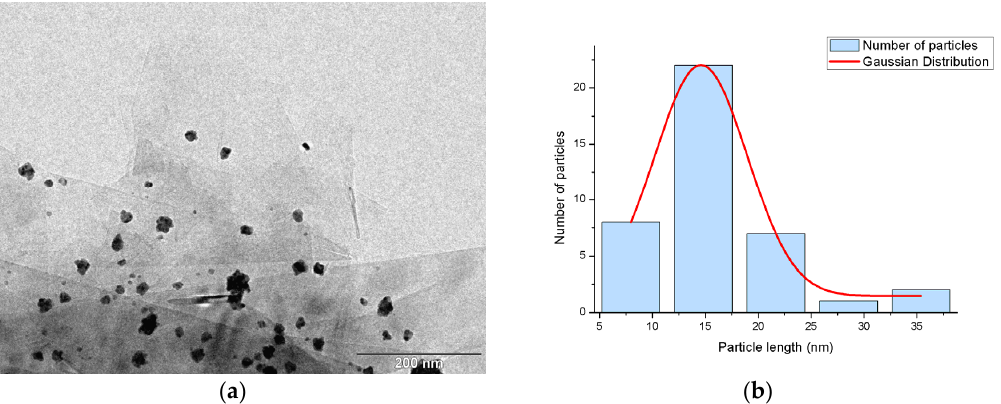
Figure 1. ( a ) Transmission electronic microscopy (TEM) image of the material G-COOH-Pd which consists of Pd nanoparticles supported on a graphite support in a mixture of phases; and ( b ) Pd-particle size Gaussian distribution.